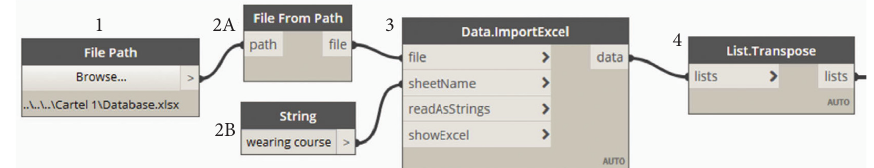
Figure 9: Importing a list to Dynamo from the Excel worksheet.